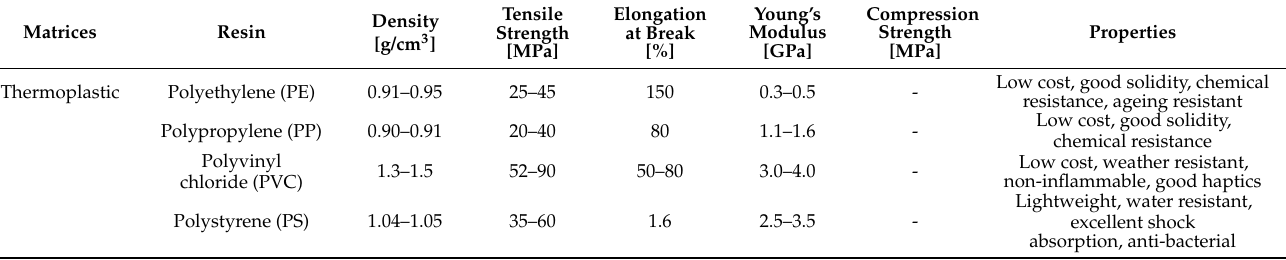
Table 4. Summary of some key properties of polymer matrices (reproduced from